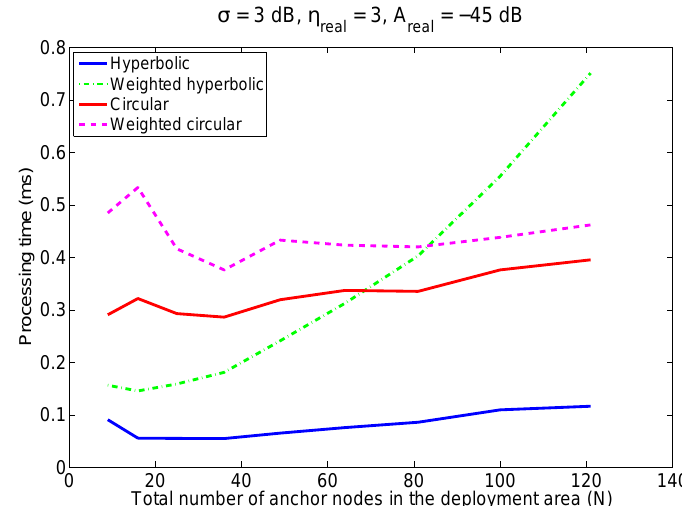
Figure 4. Average processing time of the different positioning algorithms as a function of the number of anchor nodes ( N ), for an environment with A The corresponding values of n vary between 6.3 and